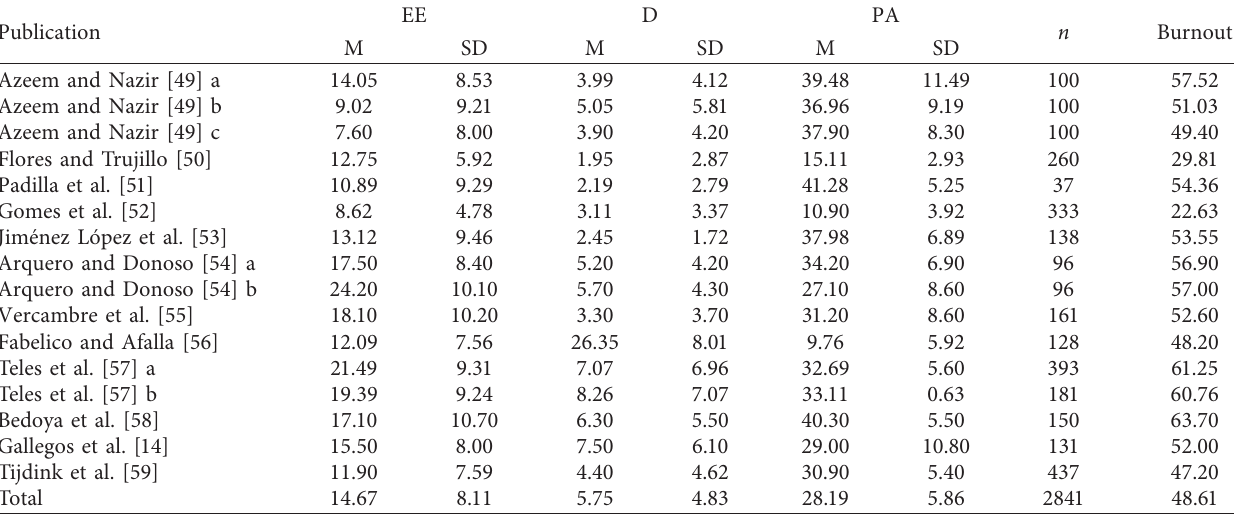
Table 5: Results of the Burnout variables.